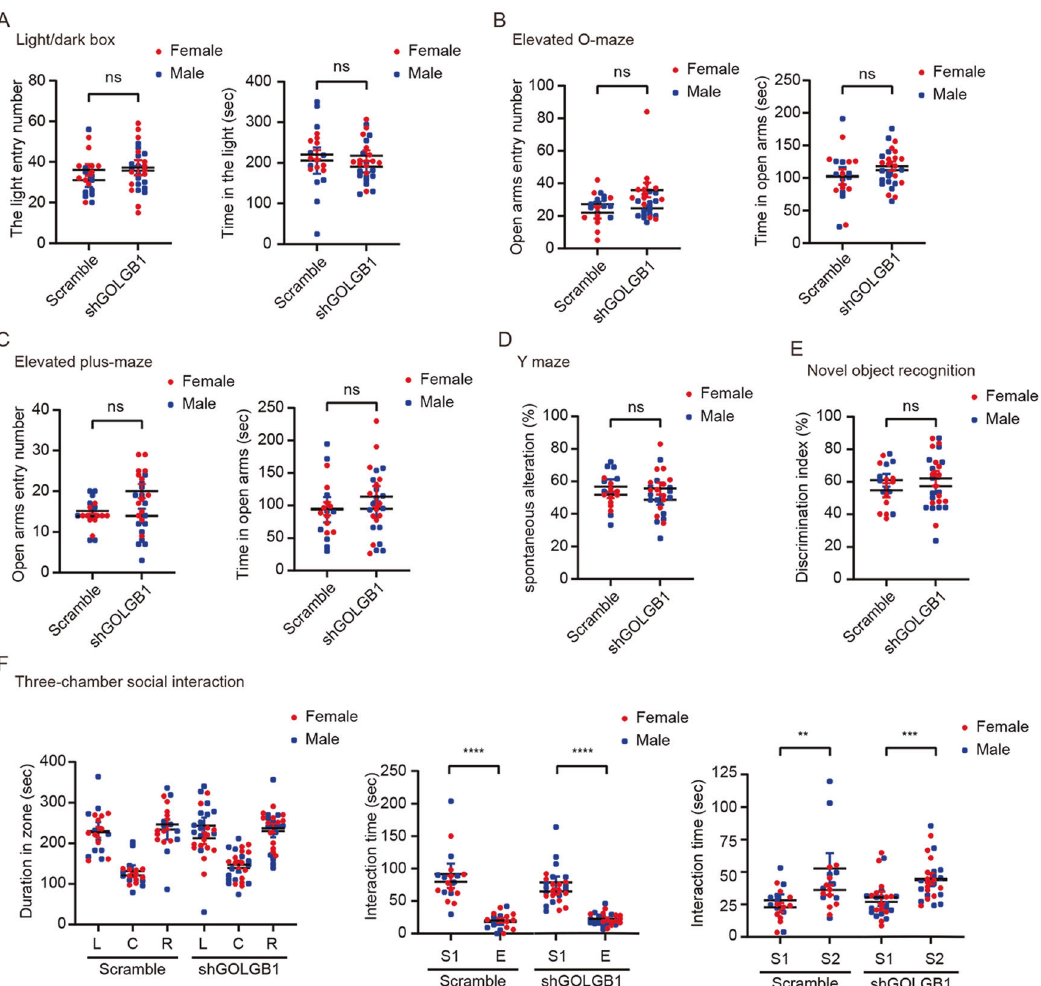
Fig. 4 Downregulation of Golgb1 has no effects on anxiety, memory, and social behaviors in mice. Mice of both sexes injected with AAVs expressing shGOLGB1 or a scrambled control shRNA were subjected to behavioral tests at 2 months of age. A In the light/dark box test, mice were studied for their time spent in the light box and entry numbers to the light box. ( B , C ) In the elevated O-maze test ( B ) and the elevated plus-maze test ( C ), mice were studied for their time spent in the open arms and open arm entry numbers. D In the Y-maze test, mice were studied for their spontaneous alternation percentage. E In the novel object recognition test, mice were studied for their discrimination index for the novel over familiar objects. F In the three-chamber social interaction test, mice were fi rst studied for their duration in the left (L), central (C), and right (R) chambers during habituation (left panel). Mice were then tested for their time spent interacting with a strange mouse (S1) and with an empty cage (E) (middle panel). Finally, mice were tested for their time spent interacting with the familiar S1 mouse and with a new strange mouse (S2) (right panel). n = 27 (13 females and 14 males) for shGOLGB1 mice, n = 19 (ten females and nine males) for scrambled control mice. ns not signi fi cant; two-tailed Student ’ s t